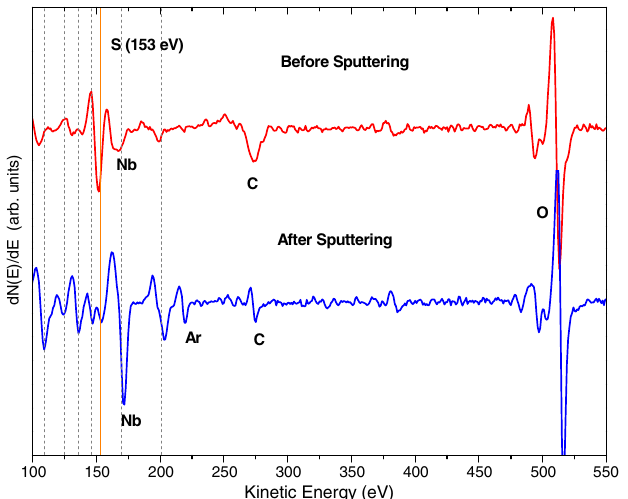
FIG. 10. A sulfur-embedded granule observed on sample 6. Sulfur is enriched on one spot (spot 2, bottom-right yellow window) but not at another spot (spot 1, upper-left window). This granule is setting on a very smooth and flat plane.